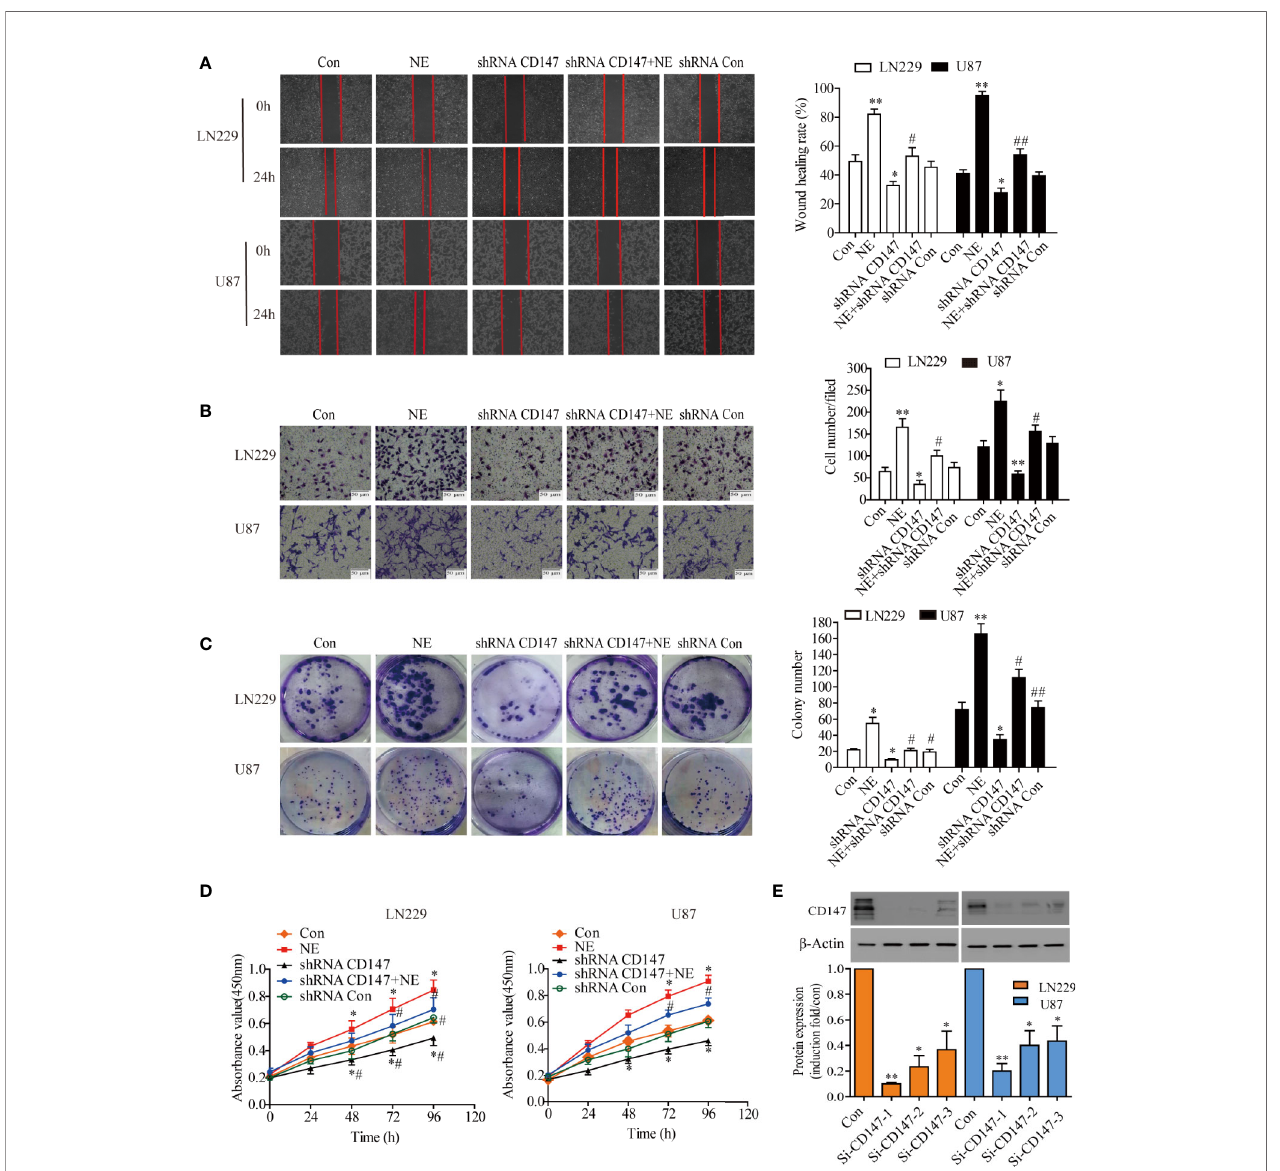
FIGURE 3 | CD147 Knockout Inhibited the Proliferation, Invasiveness, and Migration of LN229 and U87 Cells. (A) Migration ability of LN229 and U87 cells were detected by scratch assay. (B) Representative images of the invasion ability of and U87 cells [control group, norepinephrine (NE) group, shRNACD147 group, shRNA CD147 + NE group and shRNA Con] in the Matrigel invasion assays ( × 200). Quanti fi cation of invaded cells showed that interference with CD147 expression signi fi cantly inhibited the invasion of Matrigel in NE -induced LN229 and U87 cells. (C) Colony formation assay. Interference with CD147 expression signi fi cantly inhibited the formation of LN229 and U87 cell clones induced by NE (10 m mol/L). (D) CCK-8 assay (at 0, 24, 48, 72, and 96 h) in two glioma cells induced by NE (10 m mol/L). CD147-interference signi fi cantly inhibited the proliferation of two glioma cells induced by NE. (E) Detection of CD147 silencing effect by Western blot and quanti fi ed. Data are expressed as the mean ± sd. *P < 0.05. **P < 0.01 vs Con (0 m mol/L NE); # P < 0.05. ## P < 0.01 vs 10 m mol/L